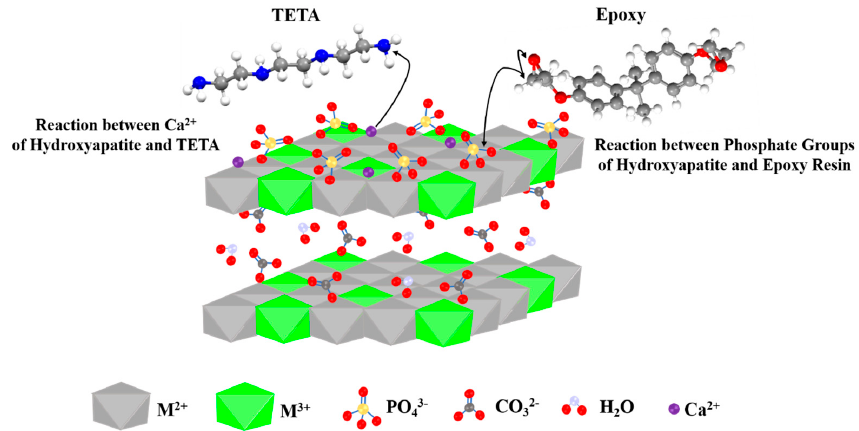
Figure 5. Possible reactions between hydroxyapatite (HA)-functionalized LDHs with epoxy resin and TETA curing agent.